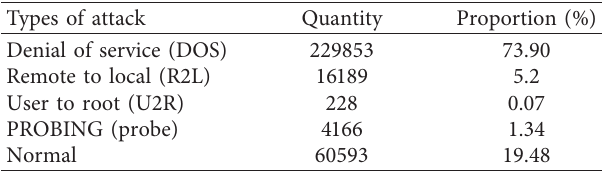
Table 3: Types of attack in KDD